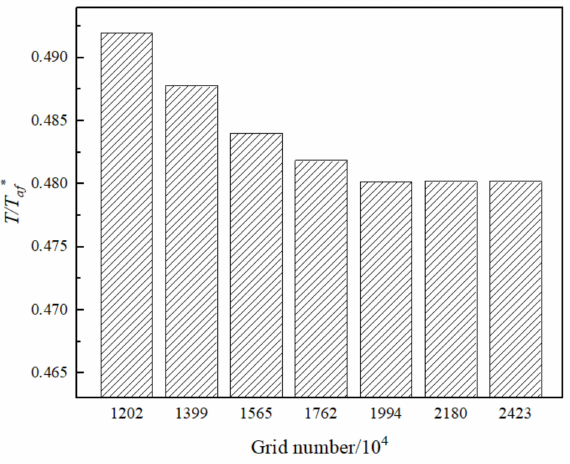
Figure 7. Non-dimensionalized average temperature of heat shield for baseline